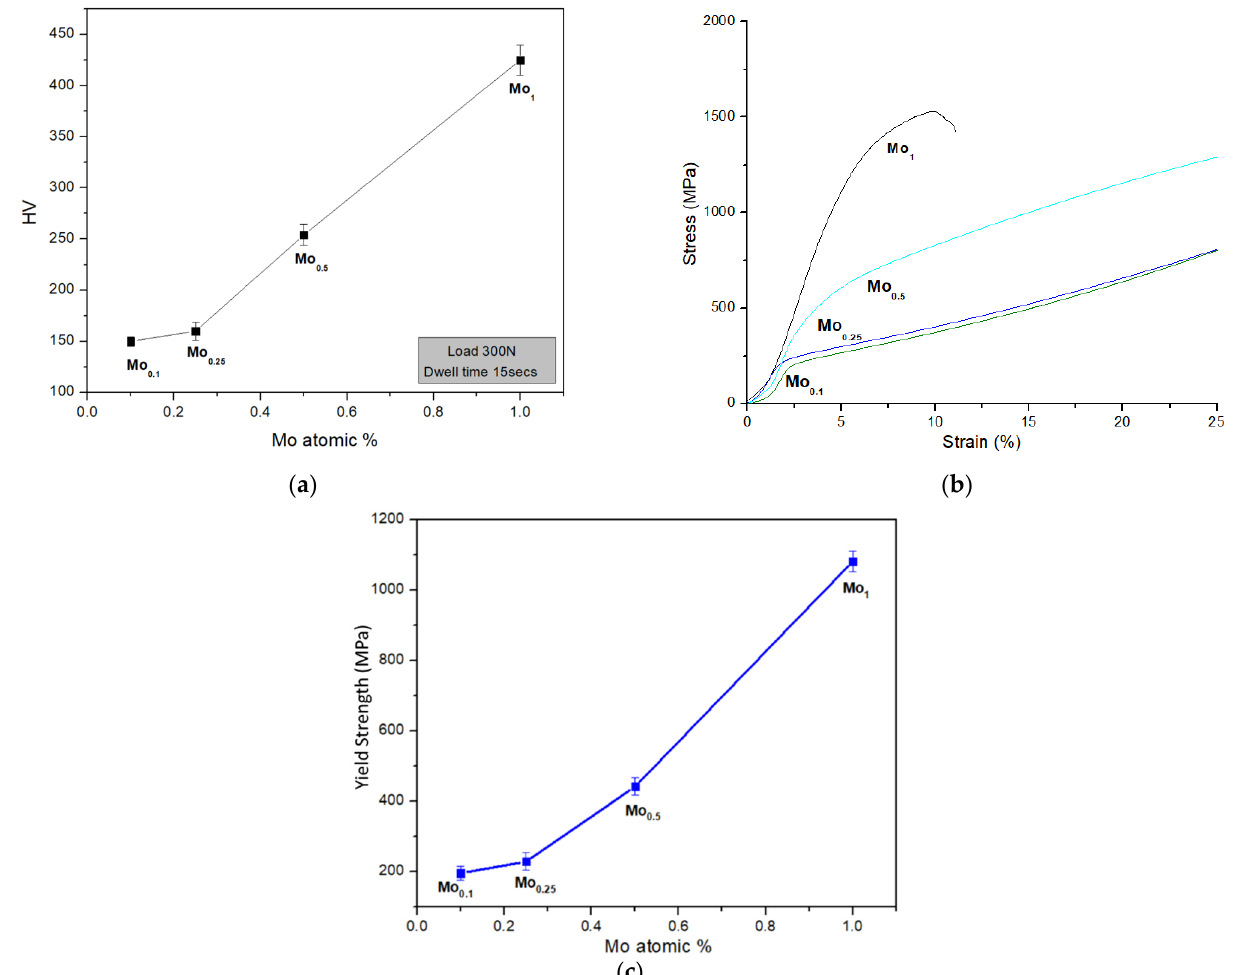
Figure 5. ( a ) Variation of hardness as a function of amount of Mo in the CoCrFeNiMo x HEA; ( b ) compression testing results for the studied CoCrFeNiMo x alloys; ( c ) variation of yield strength as a function of amount of Mo in the CoCrFeNiMo x